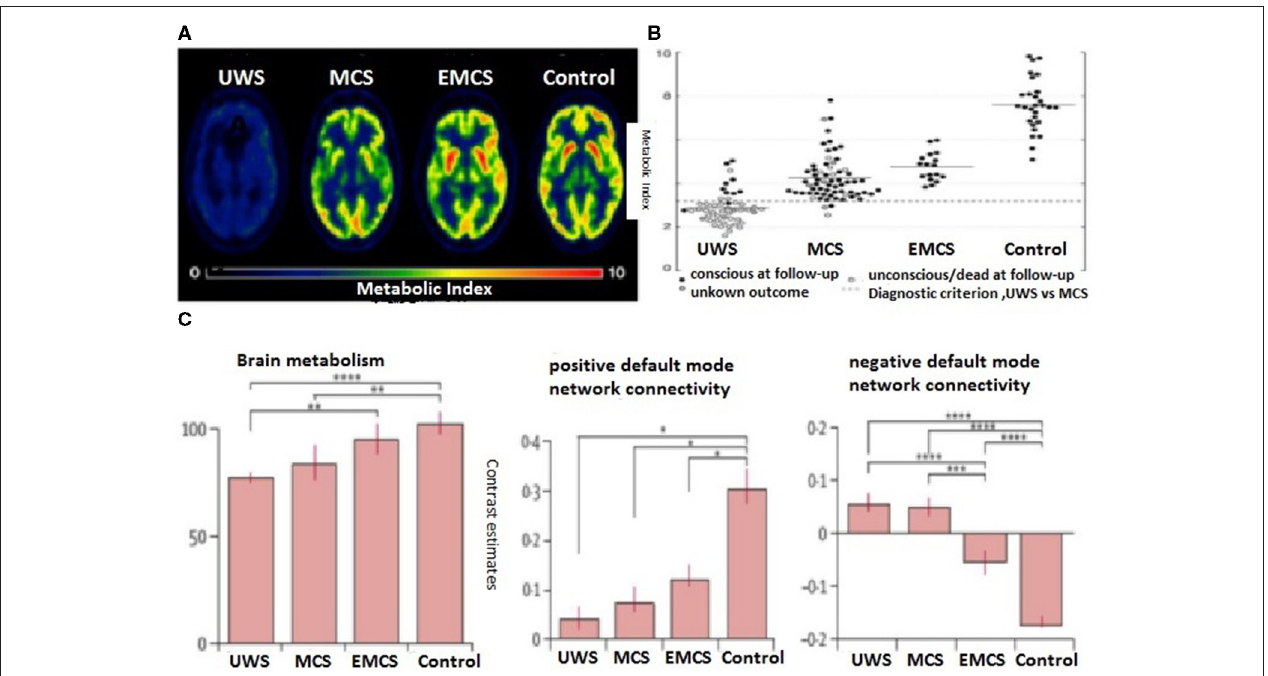
FIGURE 4 | Individual global cerebral glucose metabolism using the FDG-PET measurement (metabolic index) in a patient following traumatic brain injury (TBI) with UWS, minimal conscious state (MCS), emergence from MCS, and health control. (A) Hypometabolism is the most prominent in patients with UWS (Stender et al., 2016 ). (B) Global brain glucose metabolism distribution of quantified cortical metabolic values for all individual subjects in the pooled cohort (Stender et al., 2016). (C) (Left) Between-group differences in positive and negative default-mode networks (DMNs) and brain metabolism. Positive DMN connectivity (within network correlations) was decreased, albeit preserved, in all patient groups, from vegetative state/unresponsive wakeful syndrome (VS/UWS), MCS, and emergence from MCS (EMCS) (Stender et al., 2016); no differences were identified between the groups of patients (middle). By contrast, patients differed in negative DMN connectivity (between network anticorrelations), and negative DMN connectivity only observed in patients who emerged from MCS and healthy controls (Stender et al., 2016) (right). Brain metabolism was more preserved in patients who had emerged from MCS than in patients with VS/UWS or MCS (Silva et al., 2010). * p < 0.05, ** p = 0.01, *** p < 0.001, **** p <